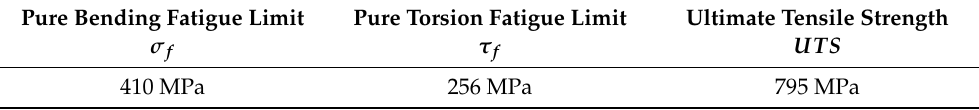
Table 2. Material